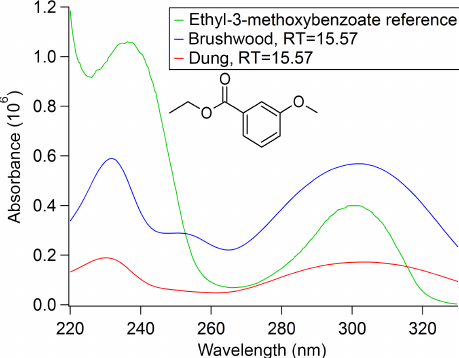
Figure 10. UV-Vis absorption spectra from the PDA analysis of cookstove BBOA samples. The blue and red curves rep- resent the background-subtracted absorbance at retention time of 15.57min for brushwood-derived PM 2 . 5 and dung-derived PM 2 . 5 , respectively. The reference absorption spectrum of ethyl-3- methoxybenzoate (green) was reproduced from the NIST Chemistry WebBook database (Talrose et al., 2017). The structure of ethyl-3- methoxybenzoate is